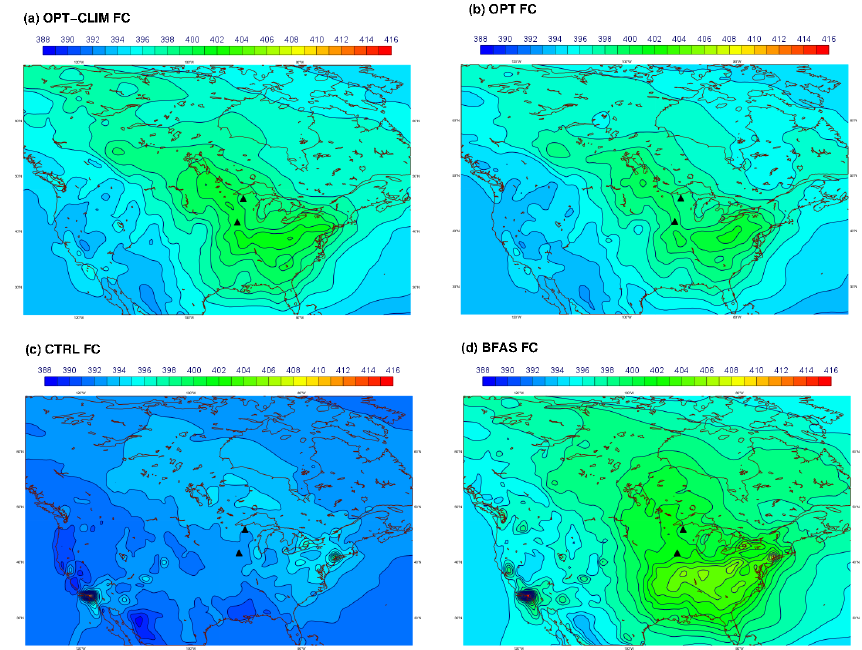
Figure 12. Monthly mean atmospheric CO 2 dry molar fraction (ppm) at the model level approximately corresponding to the highest sampling height of the Park Falls and West Branch NOAA/ESRL tall towers (see black triangles) in March 2010 from (a) OPT-CLIM, (b) OPT, (c) CTRL and (d) BFAS experiments (see Table 2 for a description of the different experiments).